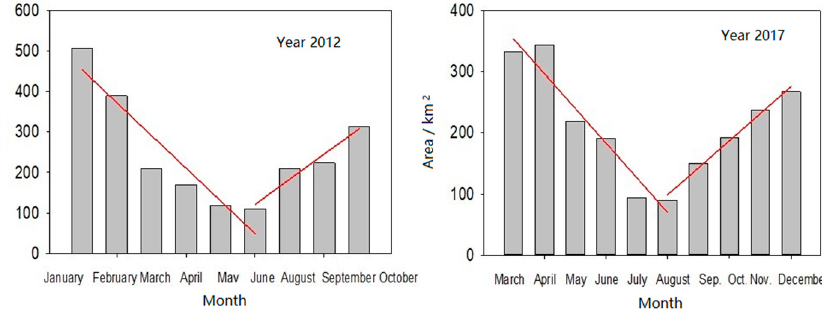
Figure 6. Intra-annual variation in water area of the terminal lake in the 1970s, 1980s, 2000s and 2010s.